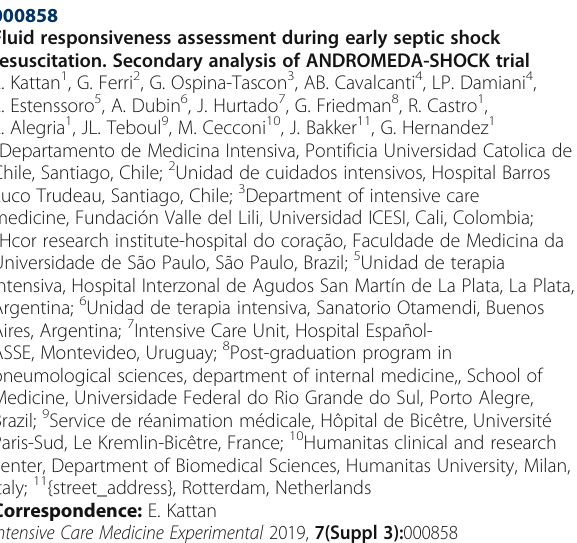
Fig. 1 (abstract 000850). Doppler spectrums of left ventricular outflow derived by echocardiography. LVOT-VTI/Vmax was hand- drawn from the spectrum. (Jozwiak M, et al. Crit Care Med.